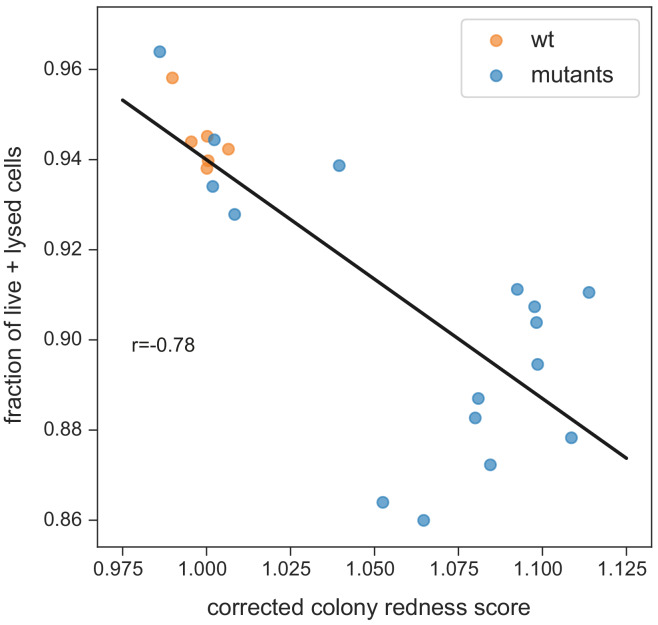
Fraction of strongly stained cells depending on colony redness score.The correlation is weaker than for the fraction of live cells only (neither burst nor strongly stained in the flow cytometer, shown in Figure 4D). This suggests that burst cells do contribute to staining in the colony (while being unstained in the flow cytometer). Note that the correlation especially breaks down for colonies with higher redness scores (which have more burst cells).